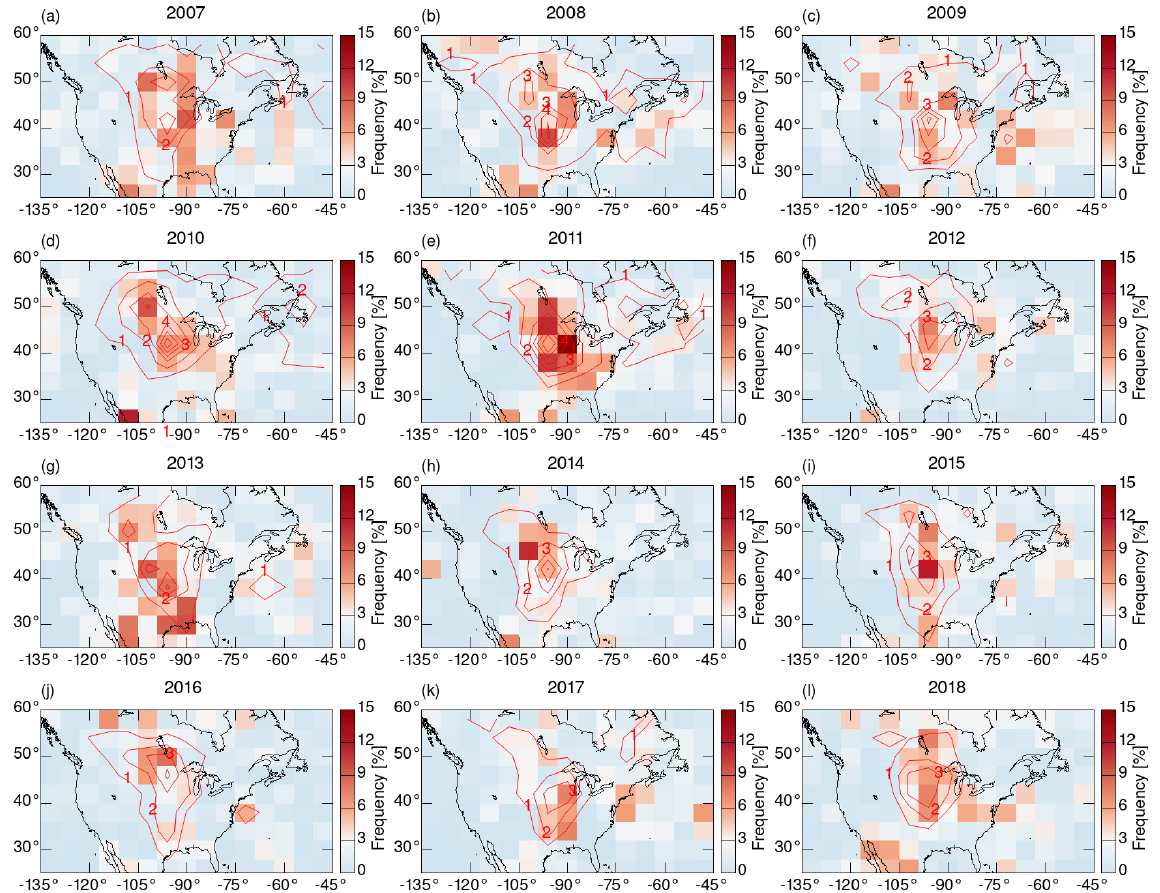
Figure 3. Nighttime mean occurrence frequencies of SICs from CALIPSO (shown as coloured boxes) and deep convection from AIRS (shown as red contour lines) in MJJA from 2007 to